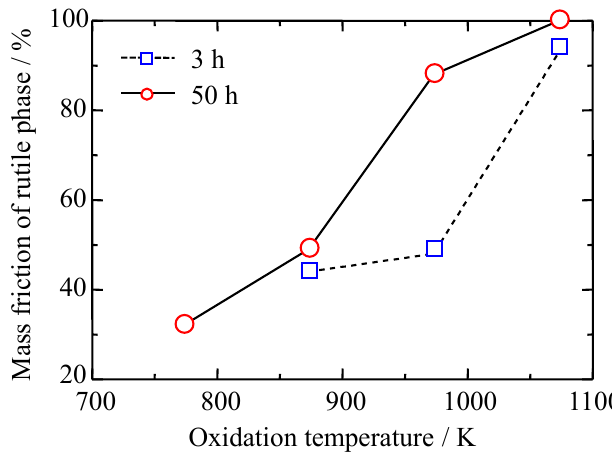
Figure 24. Mass friction of rutile phase of the Ti coatings after oxidation.